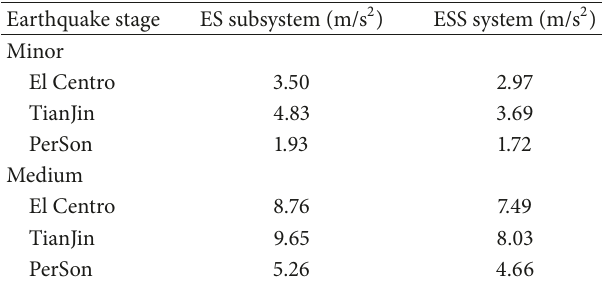
Table 4: Structure top peak